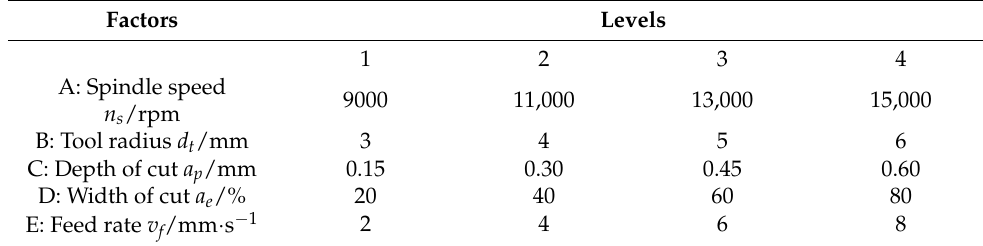
Table 1. Experimental factors and their levels.